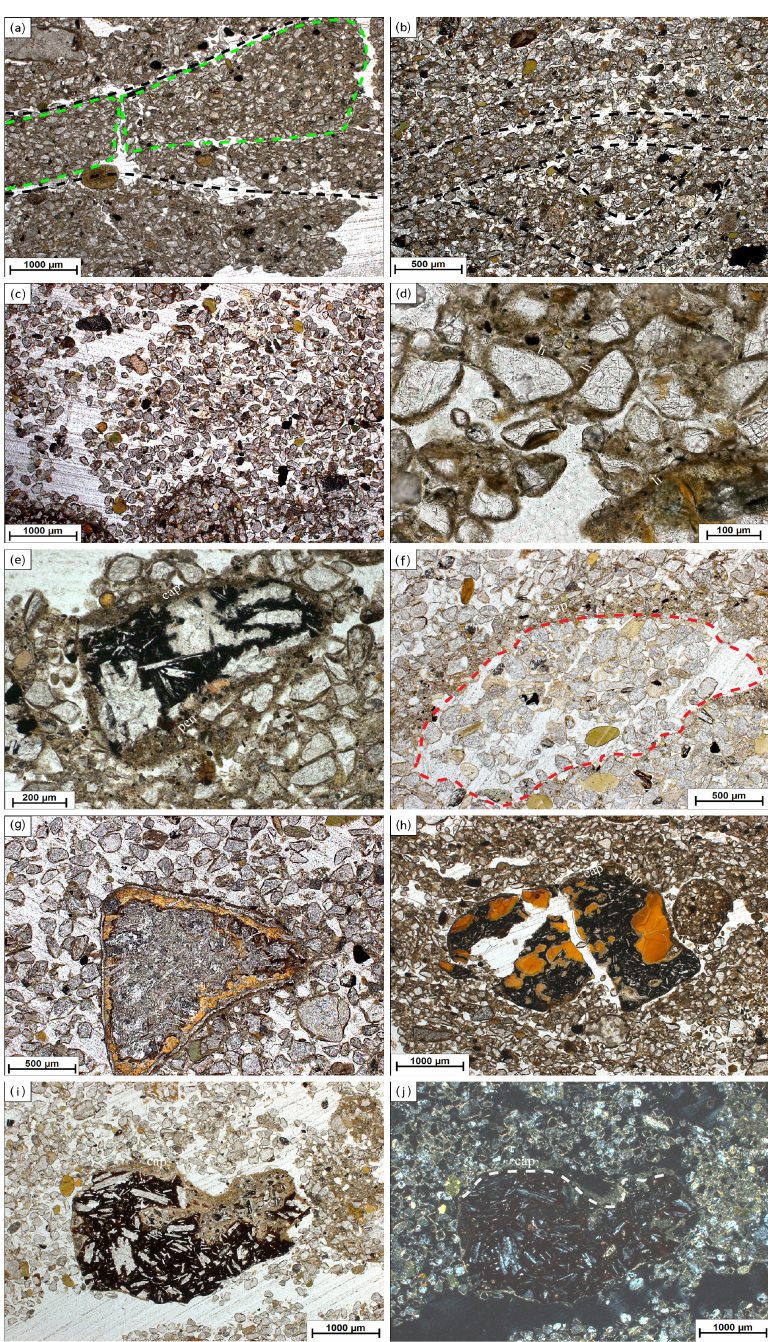
Figure 3. Images of micromorphological features found at Brandy Bay (BB) and Santa Martha Cove (SMC). Pictures were taking using plane-polarized light (ppl) and crossed polarizers (xpl). (a) BB III: highly separated lenticular platy microstructure, platy aggregates are indicated by green dotted lines, lenticular ms (microstructure) is indicated by black dotted lines, 2 . 5 × , ppl; (b) SMC IV: moderately separated lenticular platy microstructure, indicated by black dotted lines, 2 . 5 × , ppl; (c) SMC I: coarse monic microstructure, 2 . 5 × , ppl; (d) BB II: chitonic c/f-related distribution (the distribution of coarse and fine material within the thin section) and thin link cappings (li) on quartz grains, 20 × , ppl; (e) BB III: weathered rock fragment covered by silty capping (cap) and also showing a thick pendent (pen) consisting of silty material and mineral grains, 10 × , ppl; (f) SMC I: strongly weathered sandstone fragment with former boundaries, indicated by red dotted line, still visible by capping (cap), 5 × , ppl; (g) SMC I: weathered volcanic rock fragment with distinct pellicular alteration pattern, 5 × , ppl; (h) BB II: weathered and broken volcanic rock fragment with internal volcanic glass and covered by a thin clay capping (cap), (110–120µm), 2 . 5 × , ppl; (i) SMC I: weathered volcanic rock fragment with feldspar phenocrysts, covered by a dusty clay-silt capping (80– 100µm) (cap), 2 . 5 × , ppl; (j) SMC I: usage of crossed polarizers makes it possible to tell external coating (cap) from altered internal material, border indicated by grey dotted line, 2 . 5 × ,